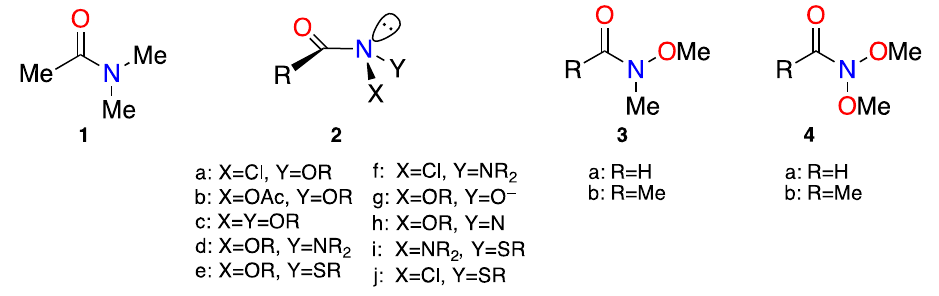
Figure 2. Resonance hybrid contributions in amides, showing that the majority of charge transfer occurs between nitrogen and carbon.